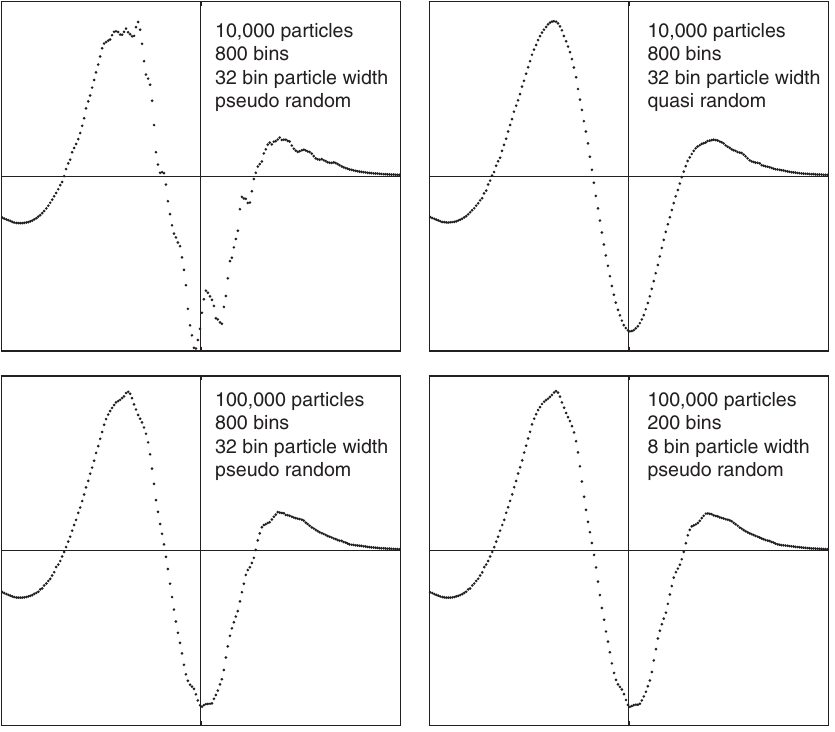
FIG. 7. Energy loss versus longitudinal position from a Bmad simulation using parameter set A. The four graphs differ in the number of particle, number of bins, particle width, and the generator used to initialize the particles.